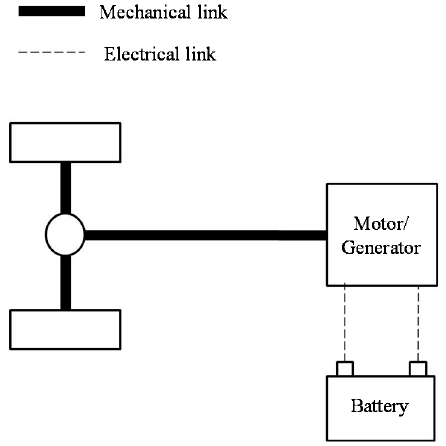
Figure 4. Electric vehicle (EV) configuration.